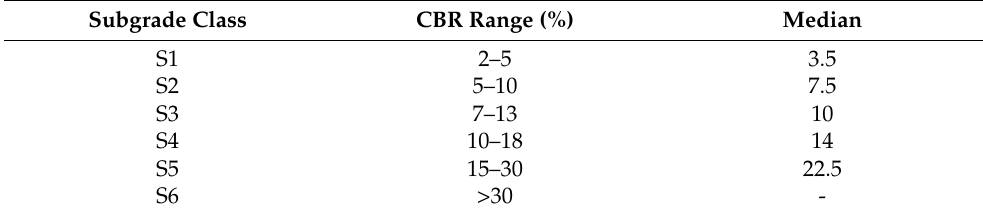
Figure 6. Effects of ( a ) lime and ( b ) VA on OMC and MDD of black cotton soil. Table 5. Subgrade soil classification in Kenya